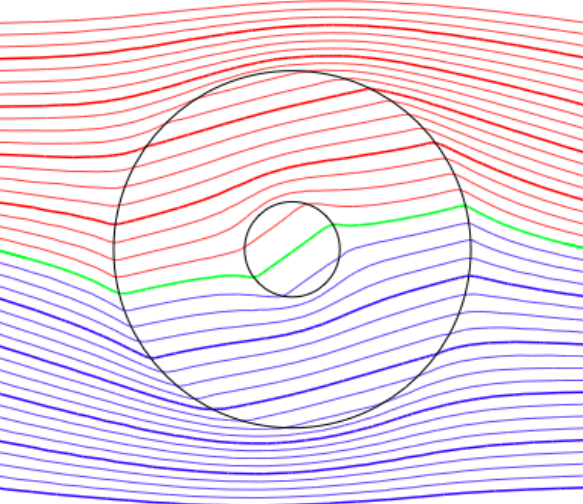
Figure 8. Equipotential contours that satisfy ∇ · J = 0 for two con- centric patches of density 2 × and 5 × the background density, and a uniform κ = 1. Although the electric field and the boundary shapes will become quite complicated as the inner patch approaches the boundary of the outer one, we can appreciate that the step bound- aries will approach each other around their 10:00 o’clock position, while growing farther apart around 04:00